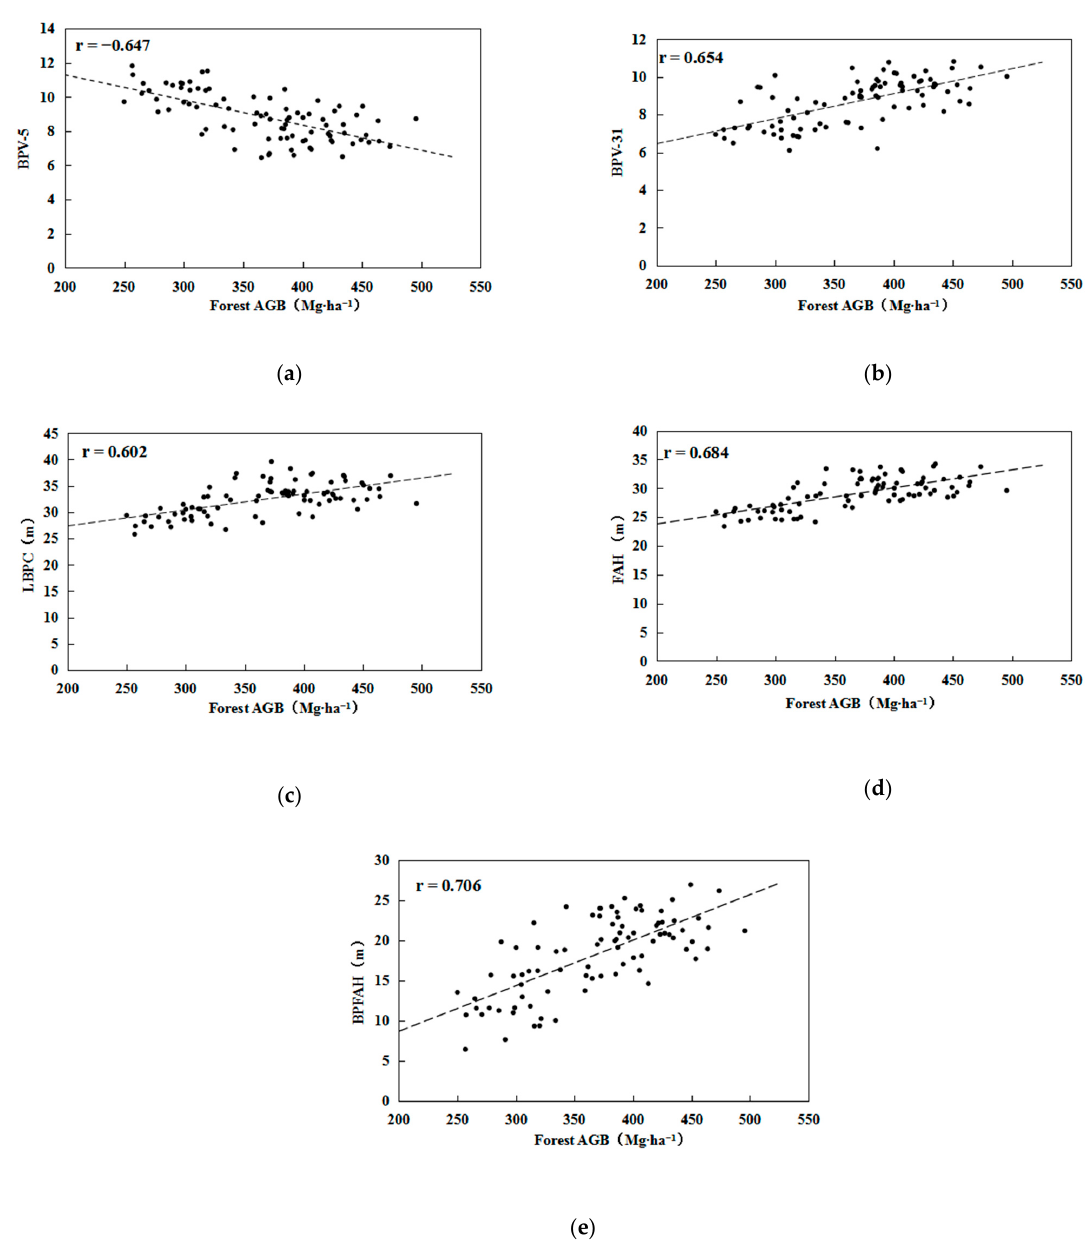
Figure 14. Correlation between the profile features and forest AGB. ( a ) BPV of 31m height layer, ( b ) BPV of 5m height layer, ( c ) LBPC, ( d ) FAH, ( e ) BPFAH.